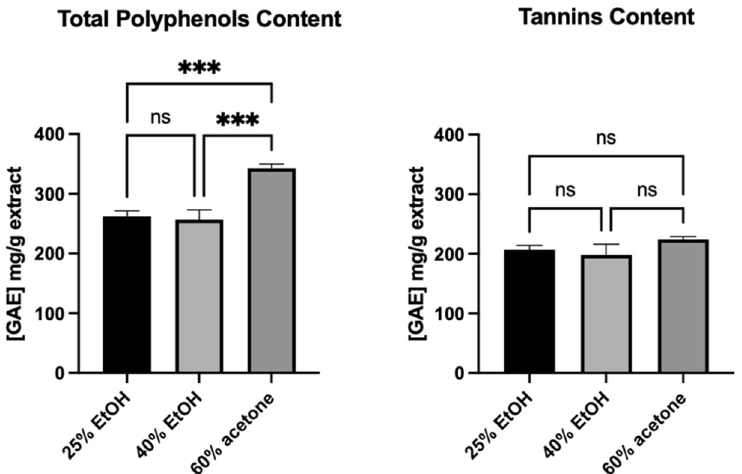
Figure 8. Total polyphenols and tannins content in studied extracts. Note that 25% EtOH, 40% EtOH, and 60% acetone means 25% ethanol extract, 40% ethanol extract, or 60% acetone extract from Reynoutria japonica rhizomes, respectively Error bars shown in this figure are means ± SD for n ≥ 3. *** Statistically significant at p ≤ 0.001, ns: not statistically significant.